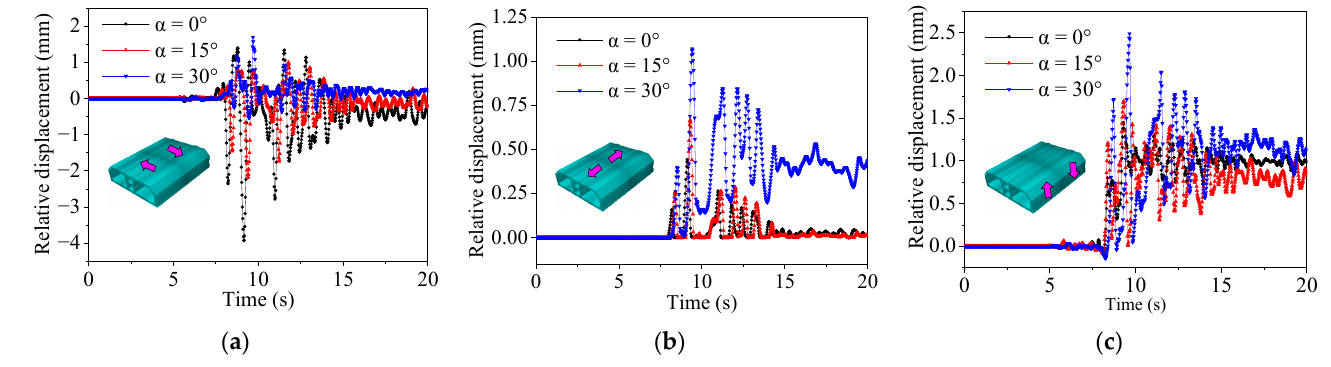
Figure 16. Relative displacement of segment joint: ( a ) horizontal; ( b ) longitudinal; ( c ) vertical.